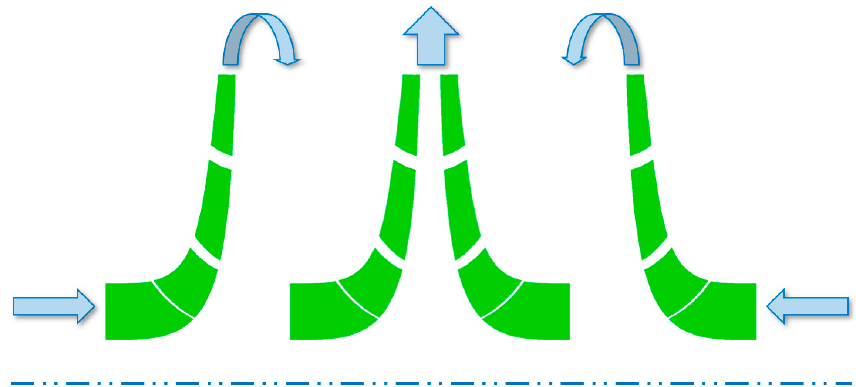
Figure 2. Schematic diagram of water flow through the impeller.